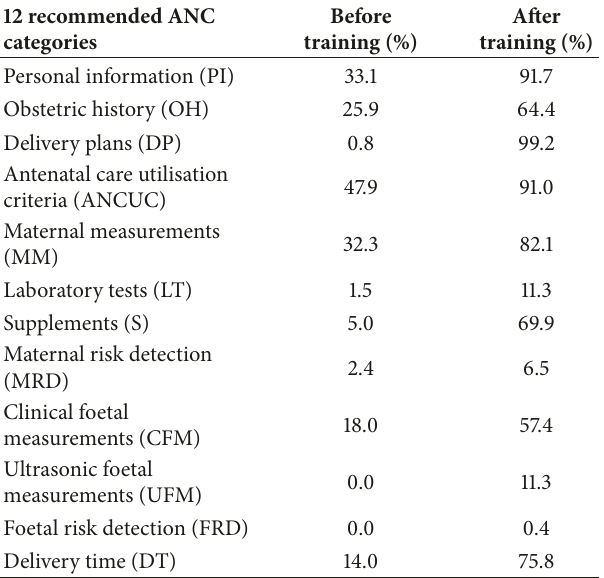
Table 3: Average data records (%) of ANC category before and after midwives’ training across urban and rural PHC